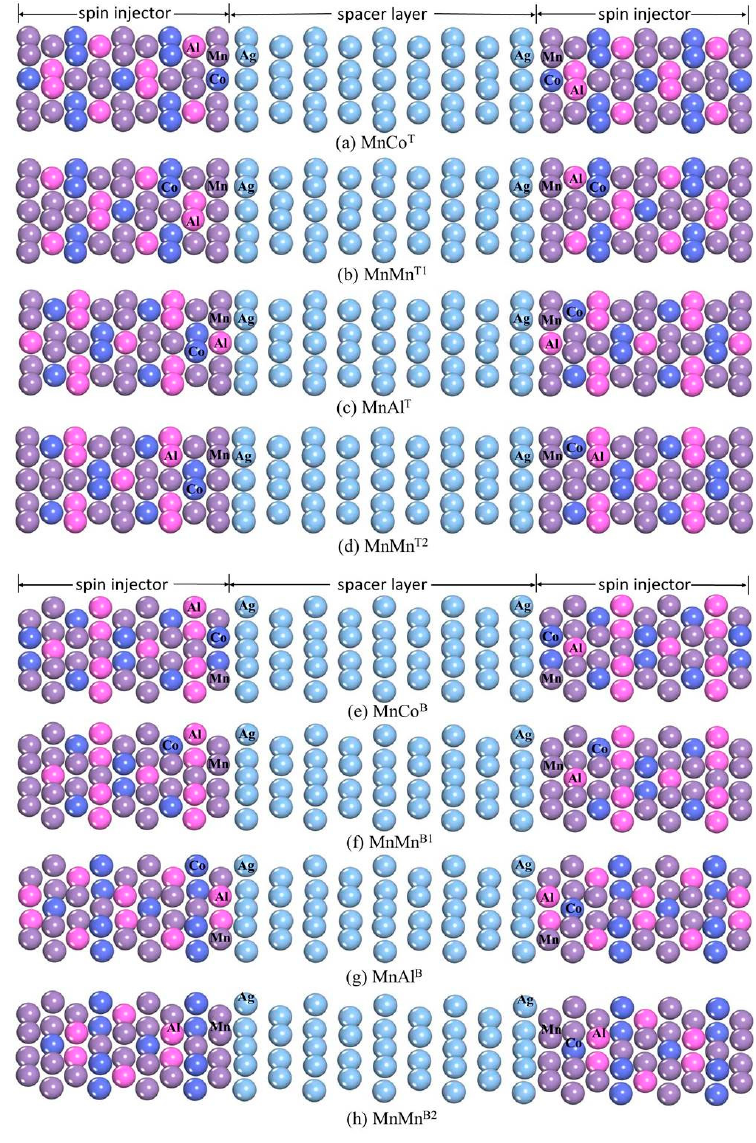
Figure 2. Various atomic terminations of the Mn 2 CoAl/Ag/Mn 2 CoAl (001) interface.